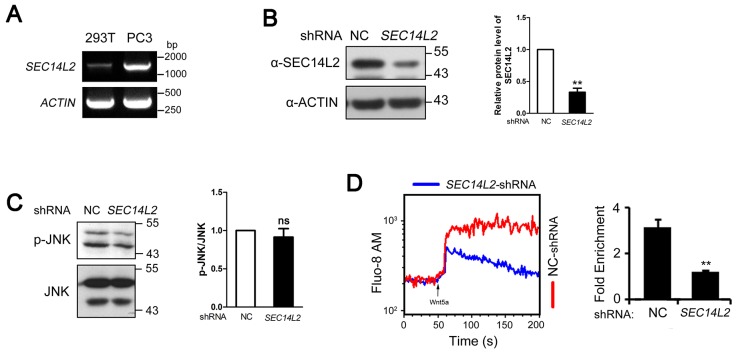
SEC14L2 depletion inhibits Wnt/Ca2+ transduction in PC3 cells.(A) RT-PCR of SEC14L2 in HEK293T and PC3 cells. (B) SEC14L2 shRNA effectiveness test in PC3 cells. Quantification of SEC14L2 protein levels based on three independent experiments is shown on the right, represented by mean ± SEM (**p<0.01). (C) Phosphorylation level of JNK in control-shRNA and SEC14L2-shRNA stably transfected PC3 cells. Quantification data from three independent experiments are shown as mean ± SEM on the right (ns, non-significant). (D) Flow cytometry analysis of Wnt5a-induced calcium signals in PC3 cells. The kinetic calcium influx was plotted over time. Red indicates the NC shRNA transfected group while blue indicates the SEC14L2 shRNA knockdown group. 400 ng/μl Wnt5a protein was used for stimulation. Data was quantified using multiple rectangular region analysis. Fold enrichment of calcium influx in NC shRNA or SEC14L2 shRNA transfected PC3 cells upon Wnt5a stimulation is shown on the right. Data are presented as mean ± SEM based on three independent experiments (**p<0.01).